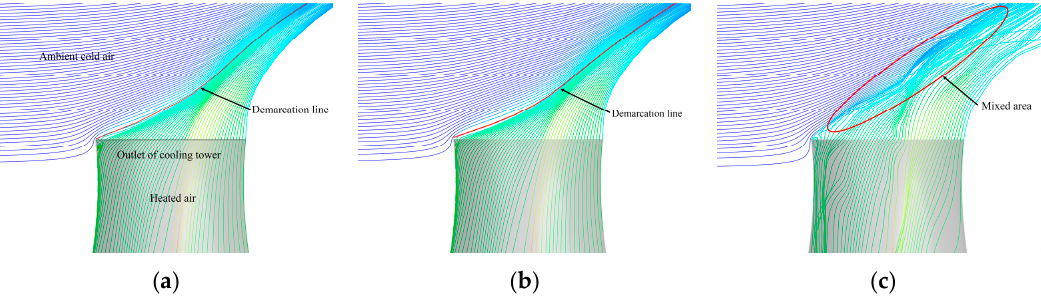
Figure 17. Comparisons of streamlines near the exit of cooling tower: ( a ) RANS; ( b ) URANS; ( c ) LES.